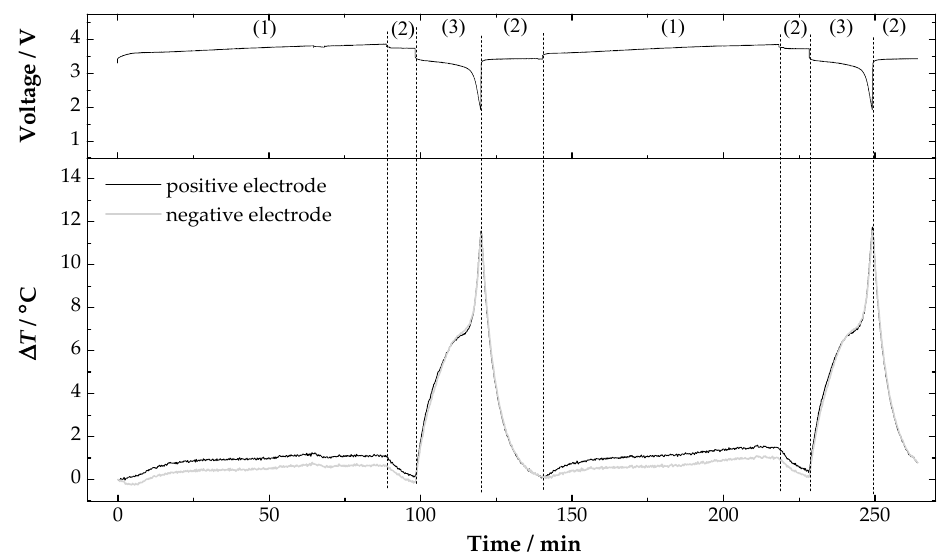
Figure 2. Voltage and temperature variations recorded during two cycling tests, in the sides of the positive and negative electrodes of the battery. ( 1 ) CC charge; ( 2 ) CV; ( 3 ) CC discharge at 1.32 C.